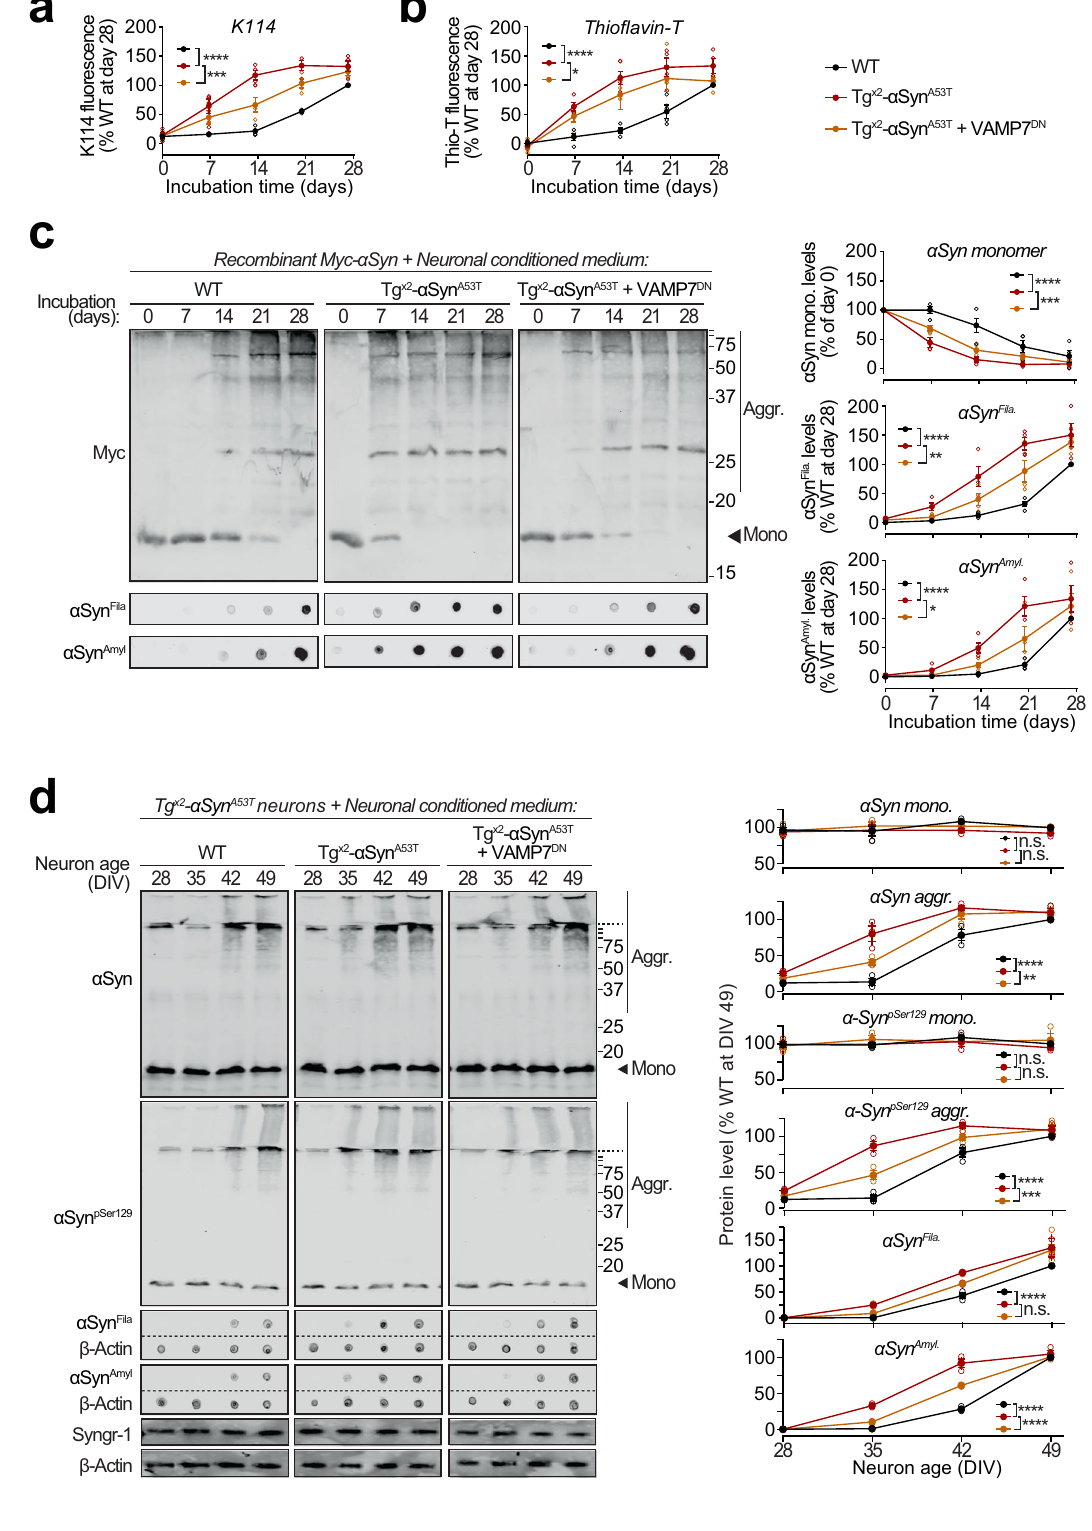
puri fi ed recombinant myc-tagged wild-type α Syn (Supplementary Fig. S10a), in the presence of extracellular media collected from neuron cultures generated either from wild-type mice, or from Tg x2 - α Syn A53T mice with or without lentiviral expression of VAMP7 DN fragment (Fig. 6a – c). Aggregation kinetics, measured by amyloid-binding fl uor- escent dye K114 (Fig. 6a) or Thio fl avin-T (Fig. 6b), were enhanced by medium from Tg x2 - α Syn A53T neurons, compared to the medium